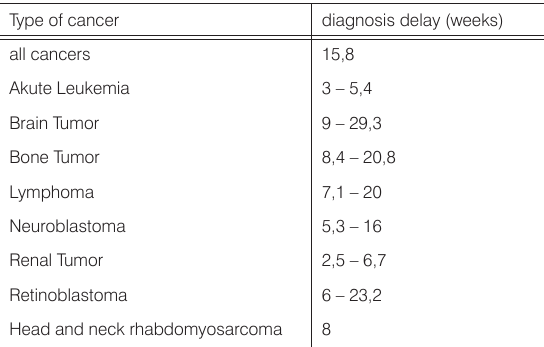
Table 2. Diagnosis delay after onset of symptoms in childhood cancer [ 3